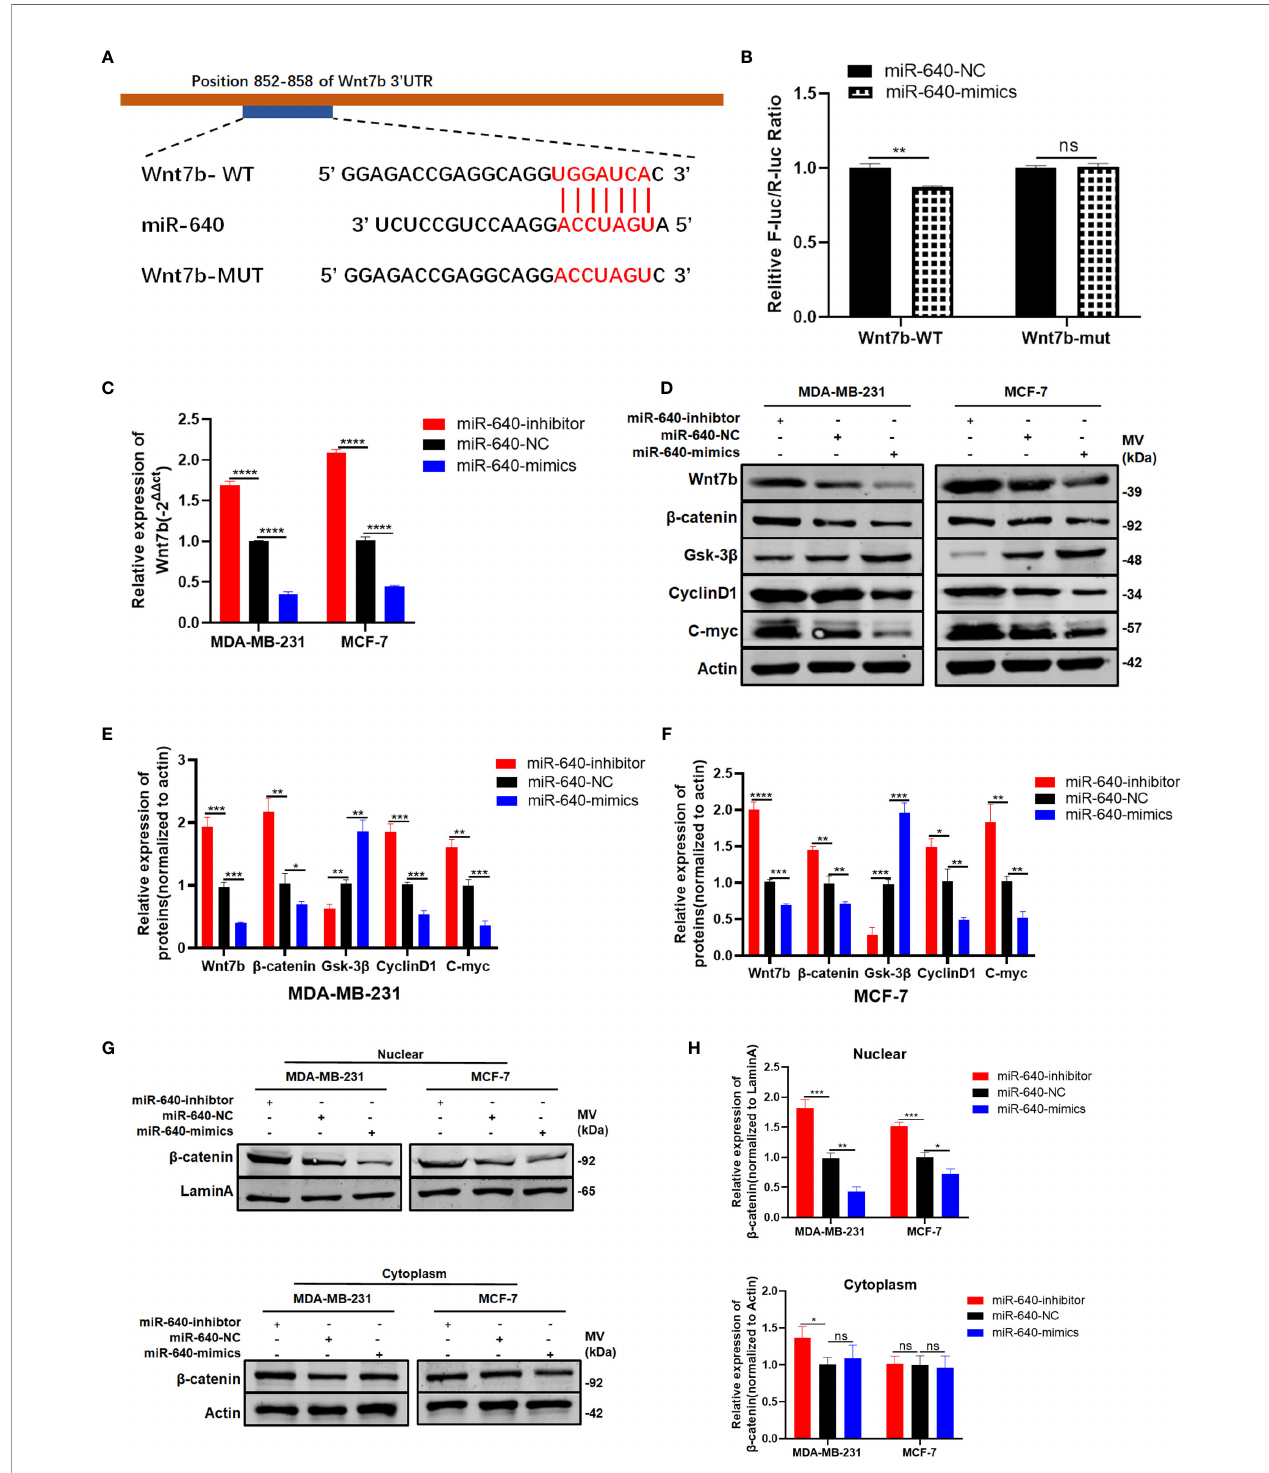
FIGURE 4 | Wnt7b is a direct target of miR-640. (A) Putative complementary site within miR-640 and Wnt7b predicted by bioinformatics analysis (TargetScan). (B) Luciferase reporter assay demonstrated that Wnt7b is a direct target of miR-640. (C) Wnt7b mRNA level was determined by RT-PCR in MDA-MB-231 and MCF- 7 cells with different treatment. (D – F) Representative Western blotting and quanti fi cation of Wnt7b, b -catenin, Gsk-3 b , Cyclin D1 and C-myc in MDA-MB-231 and MCF-7 cells with different treatment, b -actin was used as a control. (G, H) Representative Western blotting and quanti fi cation of b -catenin in nuclear fraction and cytoplasm fraction of BC cells with different treatment, LaminA was used as a control. *p < 0.05; **p < 0.01; ***p < 0.001; ****p < 0.0001. "ns" means not statistically signi fi cant and represents P <